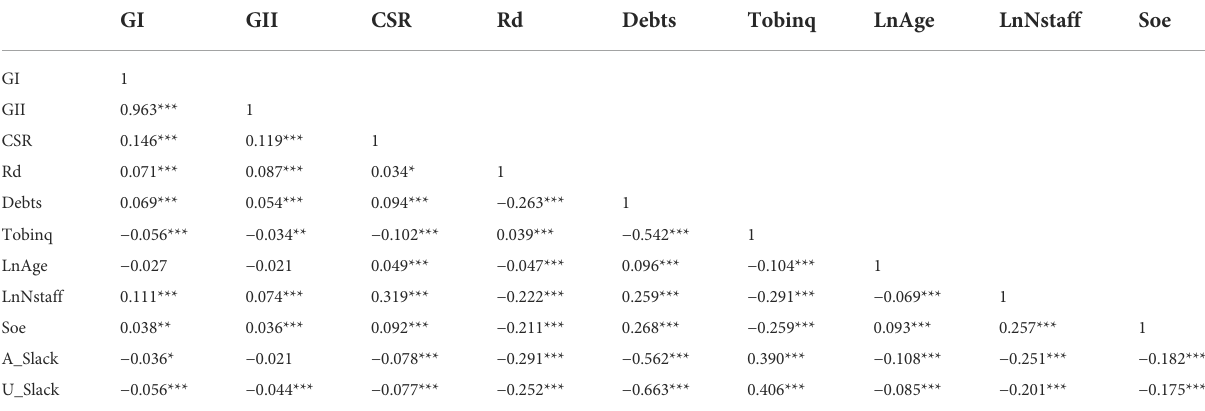
TABLE 3 Correlation coef fi cient